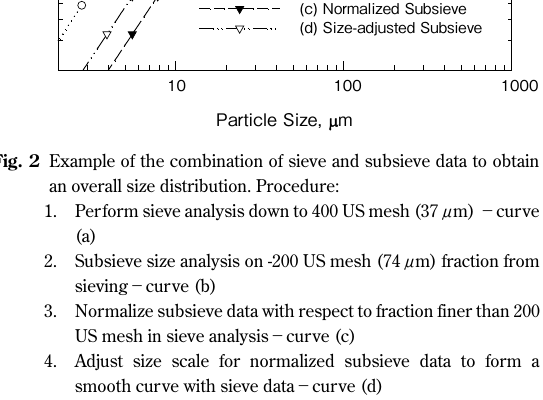
(c) Normalized Subsieve (d) Size-adjusted